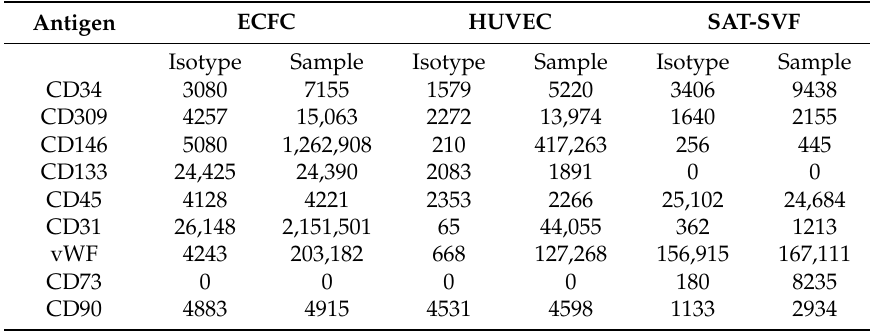
Table 1. Median fluorescence intensities registered for di ff erent antigens and cell lines during flow cytometry